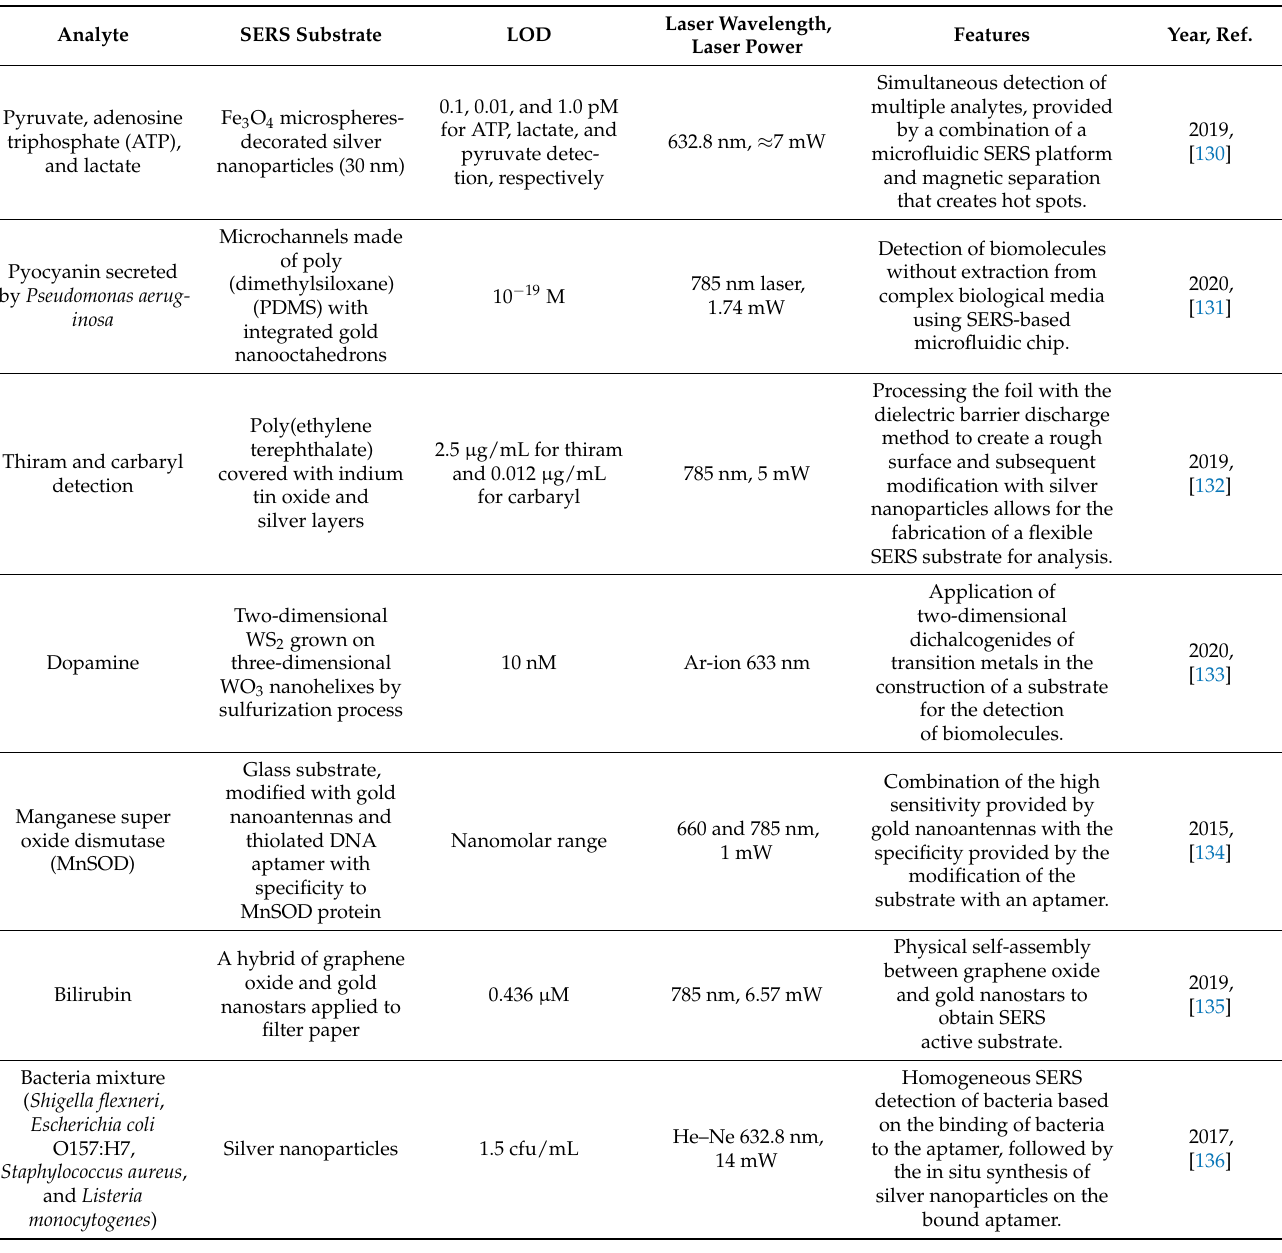
Table 2. SERS and SERS-combined techniques for direct label free